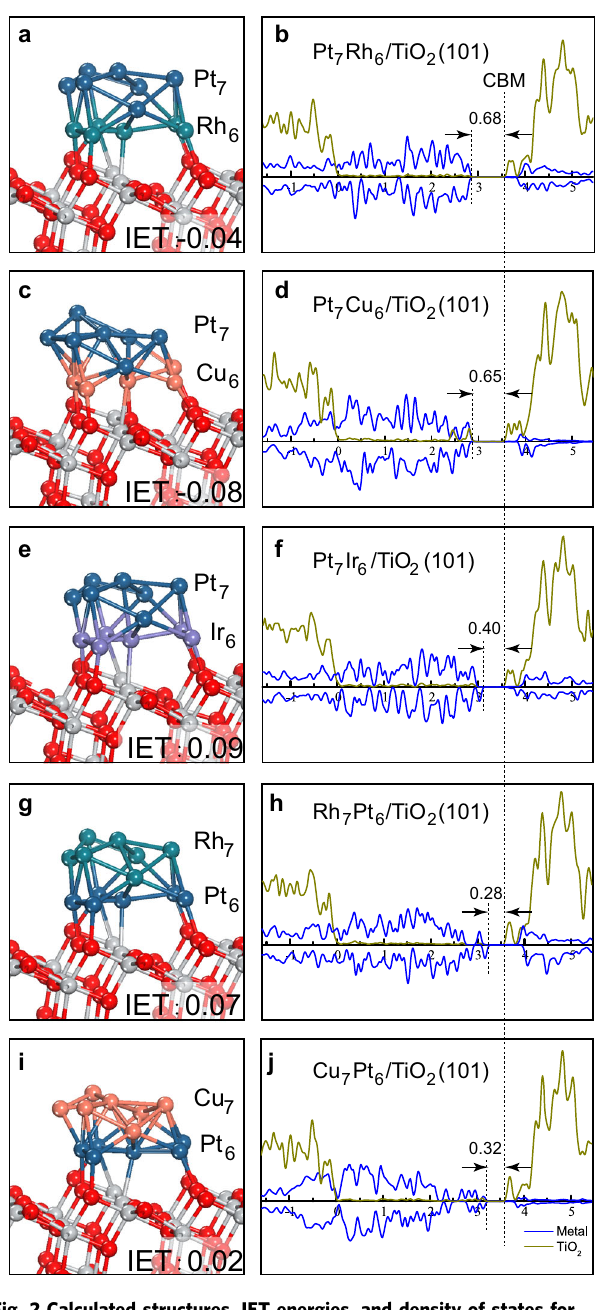
Fig. 2 Calculated structures, IET energies, and density of states for bimetallic metal/TiO 2 composites. a , b for Pt 7 Rh 6 /TiO 2 (101), c , d for Pt 7 Cu 6 /TiO 2 (101), e , f for Pt 7 Ir 6 /TiO 2 (101), g , h for Rh 7 Pt 6 /TiO 2 (101), and i , j for Cu 7 Pt 6 /TiO 2 (101), respectively. The DOS (density of states; using the hybrid HSE06 functional) for M 13 cluster and for TiO 2 surface are represented by blue and yellow-green curves, respectively. The valance band edge of TiO 2 is uniformly aligned to zero in DOS, and the vertical dot lines indicate the TiO 2 CBM and the E f position, respectively. Calculated IET energies are also given in